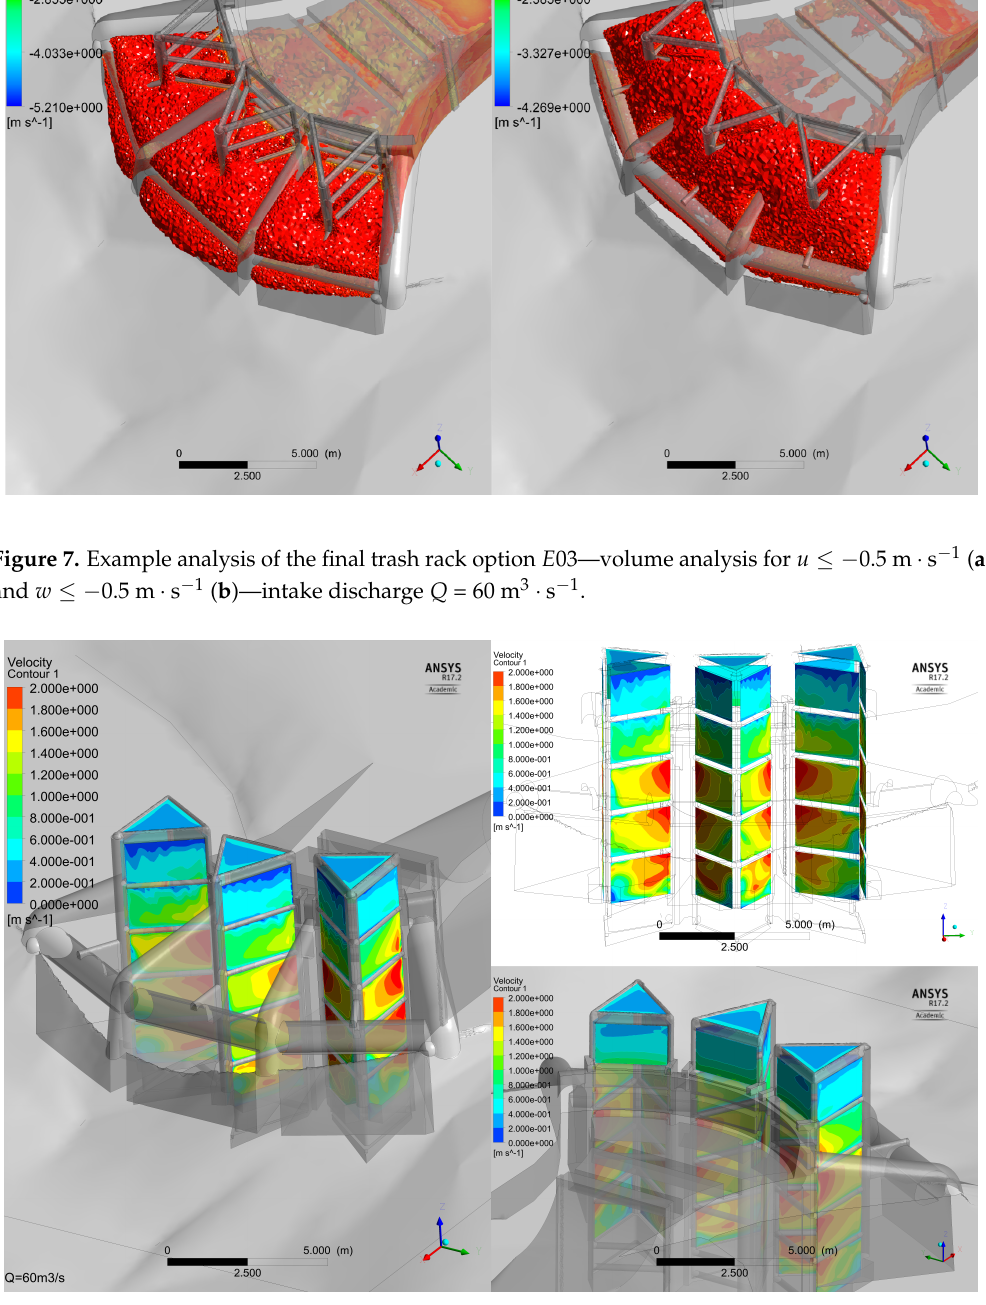
Figure 8. Example analysis of the final trash rack option E 03—contour value of the velocity on the outside of the trash rack with a color bar between 0 and 2 m · s − 1 —intake discharge Q = 60 m 3 · s − 1